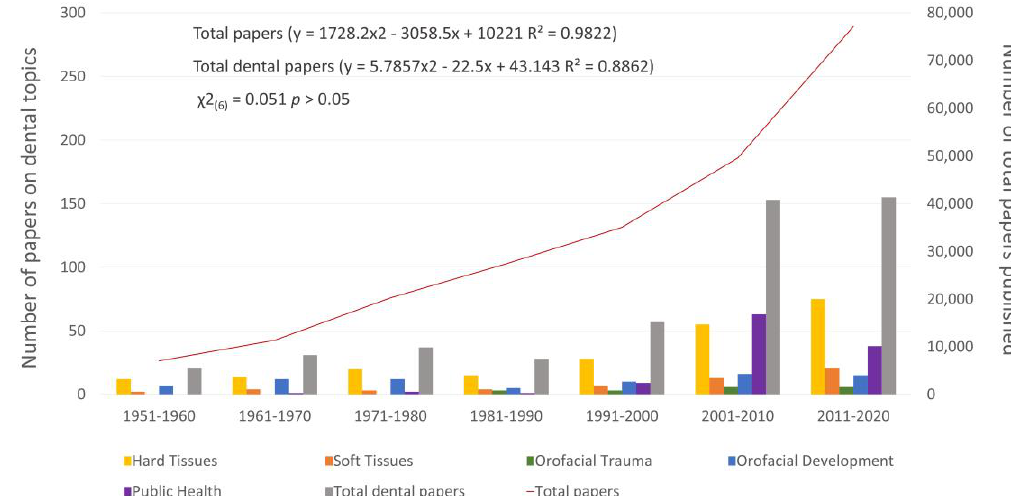
Figure 3. Number of total papers, number of papers on dental issues (total and per area) published in pediatric journals over the last seven decades (1951 – 2020). Trend coefficients are reported for the total papers and total dental papers.